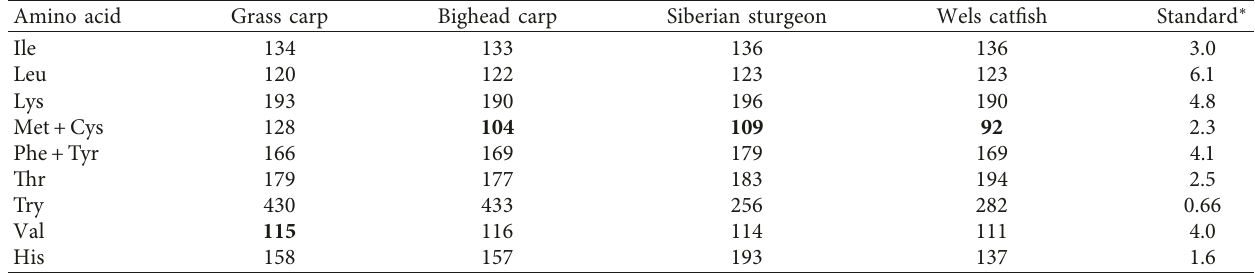
Table 5: PDCAAS (Protein Digestibility-Corrected Amino Acid Score) for protein of grass carp, bighead carp, Siberian sturgeon, and wels catfish (%). Amino acid